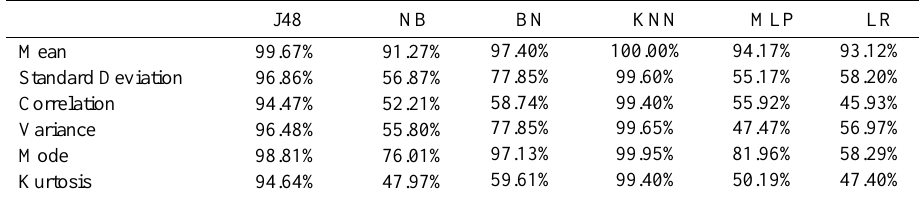
Table 3. Percentage of accuracy – algorithm vs. algorithm and feature vs. feature (TP